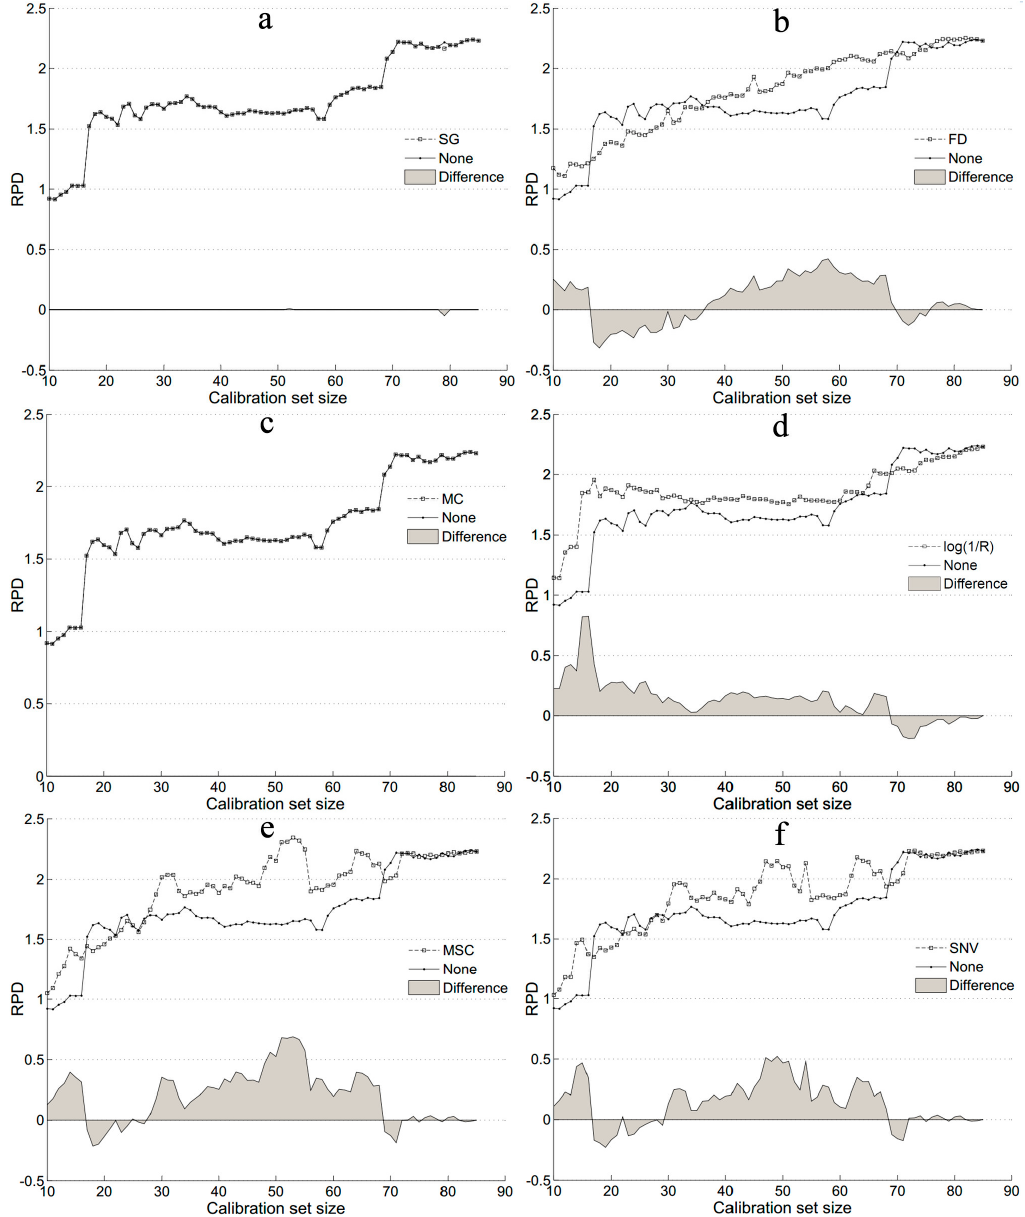
Figure 3. The results of pretreatment’s (hollow square) influence on sample selection. None (black circle) denotes the result of sample selection without pretreatment. SG denotes Savitzky–Golay smoothing ( a ). FD denotes first derivative ( b ). MC denotes mean centering ( c ). log(1/R) denotes logarithmic function ( d ). MSC denotes multiplicative scatter correction ( e ). SNV denotes standard normal variate ( f ). RPD denotes residual predictive deviation.